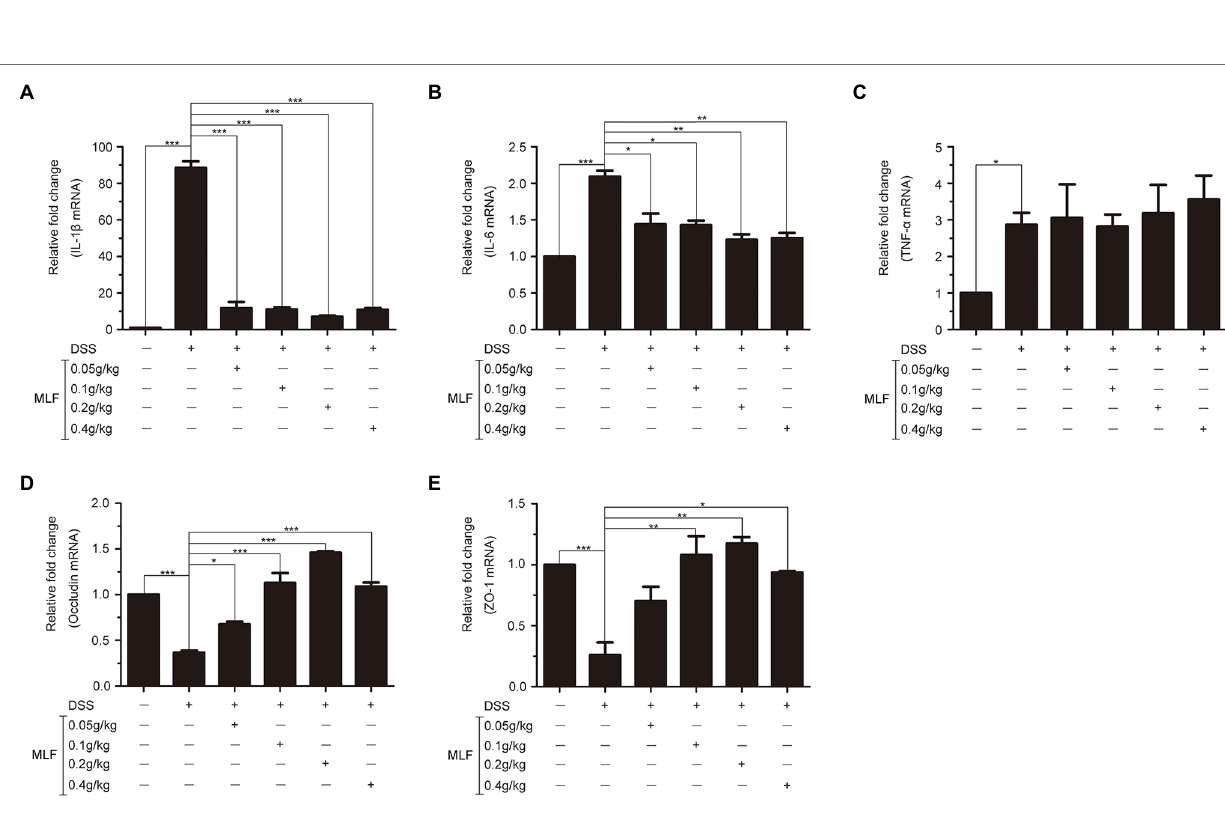
FIGURE 7 | Effects of MLF on the mRNA levels of inflammatory cytokines and tight junction protein in mice. The levels of IL-1 β (A) , IL-6 (B) , TNF- α (C) , Occludin (D) , and ZO-1 (E) in colon of DSS-induced UC mice were detected using real-time reverse transcription PCR (RT-PCR). MLF groups were statistically analyzed with the DSS group. Data are expressed as means ± S.E. * p < 0.05, ** p < 0.01, and *** p <